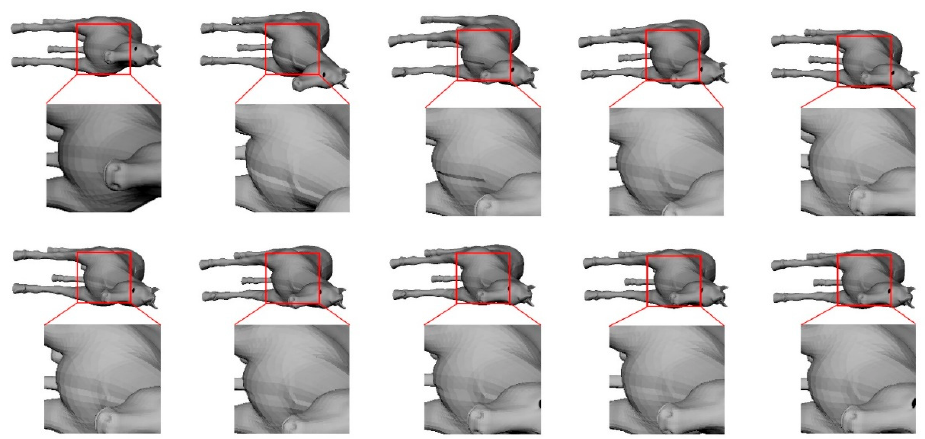
Figure 2. PBD deformation results of our horse model. From the first to the last pose, they are frame 1, 20, 30, 40, 50, 60, 70, 80, 90, 100. The simulation results demonstrate that PBD has a high-quality visual deformation performance.